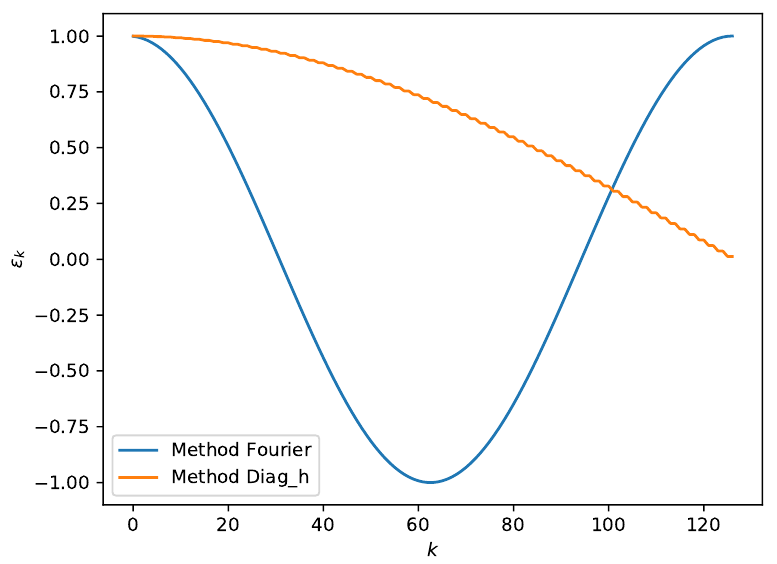
Figure 5: In this example we diagonalised the Hamiltonian with two different methods. Using the Fourier transform method we obtain the energies specified in (114). These energies are both positive and negative. Using the Diag_h method of F_utilities we obtain just positive energies. The difference in the diagonal en- ergies comes from the fact that Diag_h , for every eigenmode with negative energy, substitutes creation and annihilation operators in order to redefine the energy as pos- itive, and then reorders the modes in order to have the energies in descending order. If we diagonalise with the Fourier transform then the ground state is obtained filling all the modes with negative energy. If we diagonalise with Diag_h then the ground state corresponds to the empty